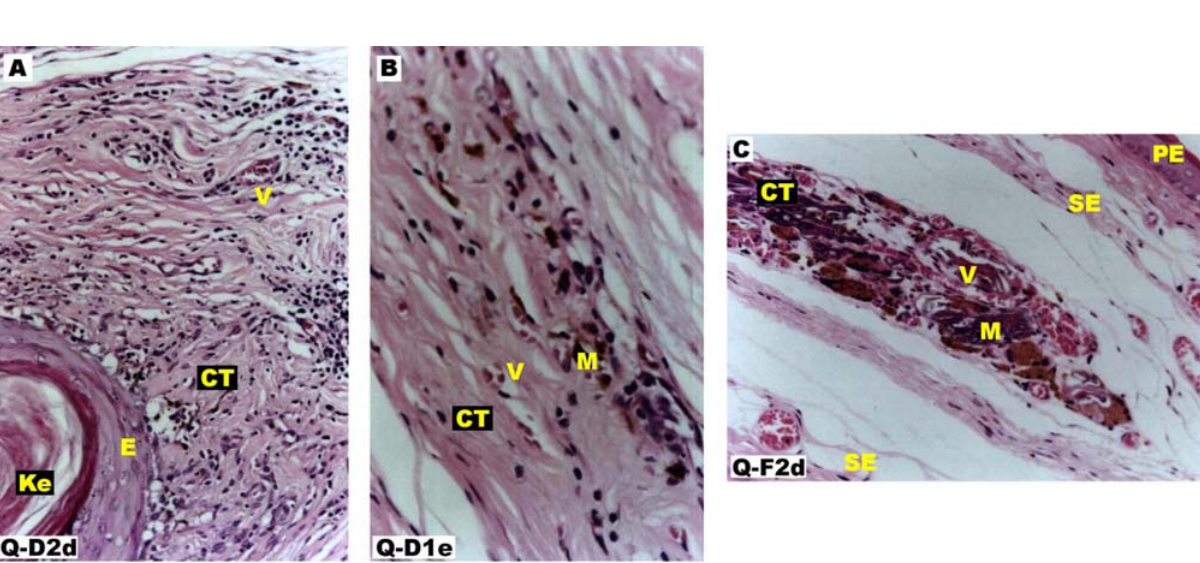
FIGURE 9 - Microscopic fragments of grafted keloid from 42 days to 168 days (HE). A) At 42 days, presence of whole epithelium with keratin cysts (x200). B) At 42 days, besides the presence of only dregs of epithelium, the melanocytes presence may be observed (x400). C) At 168 days, the presence of dysmorphic epithelium with melanocytes and vases in conjunctive tissue may be observed (x400). [PE = Pouch epithelium; E = Epithelium of the grafted fragment; Ke = Keratin; SE = Sub-epithelium of the cheek pouch; V = Blood vase in the grafted fragment; I = Inflammatory infiltrated; M = melanocytes; CT = Conjunctive